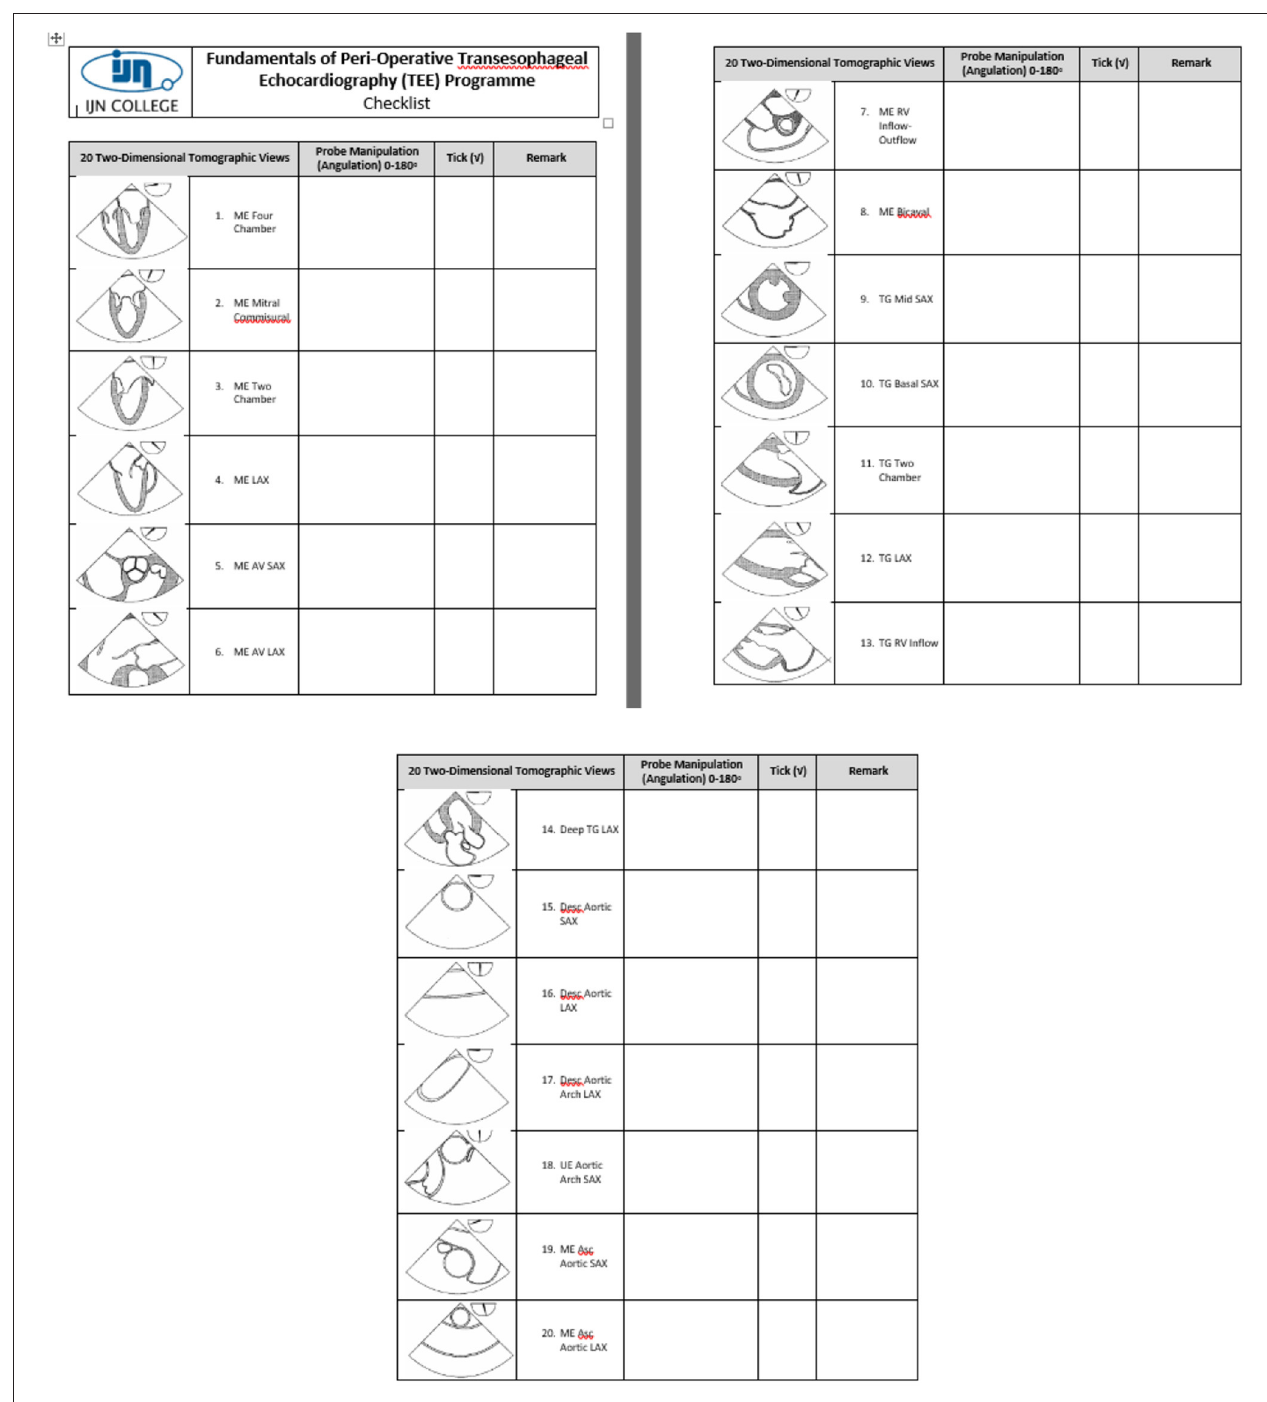
FIGURE 3 | Contents of the checklist include the thematic image of the tomographic views with the appropriate probe position and